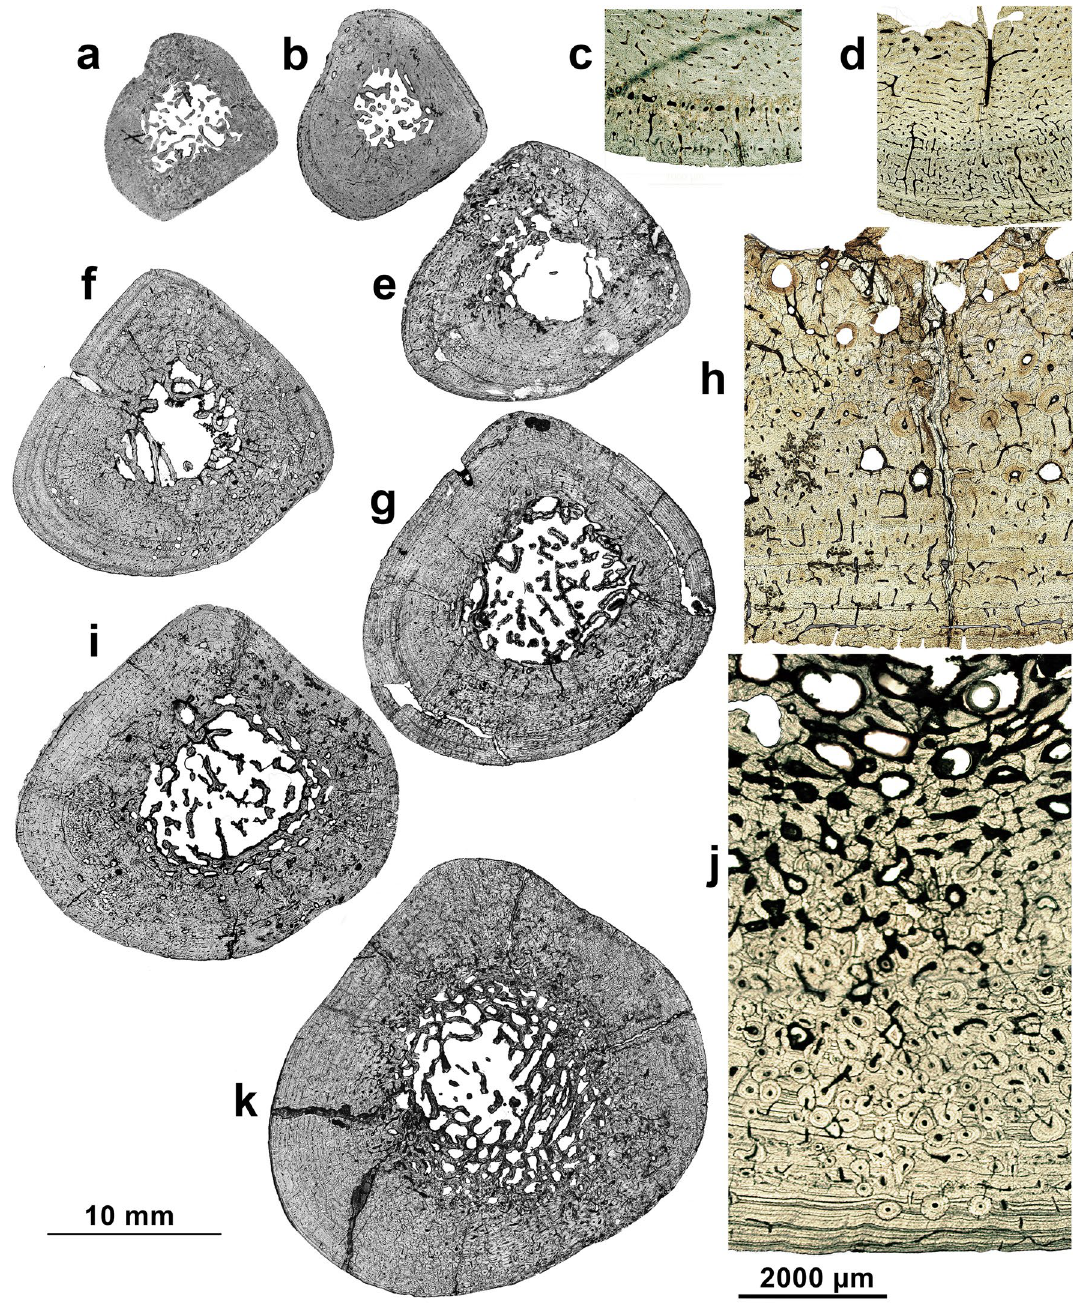
Figure 2. Tibia midshaft sections of P. falconeri . Representation of tissue types in histological sections of an ontogenetic series of tibiae (( a , b , f , e , I , g , k ); anterior crest upper); magnifications ( c , d , h , j ; medullary cavity upper). ( a ) neonate (T106) showing parts of the birth line; ( b , c ) (T1): 1 year; longitudinal and radial osteons after the first winter LAG; ( d ) (T135), ( e ) (T138): 2.5–3 years ‘Fibro-lamellar complex’ (FLC) with longitudinal, oblique and radial osteons; ( f ) (T2): 4 years; ( g ) (T139): 7 years; ( h ) (T 45): 9 years, still showing active growth (open canals at the outer cortex); ( i ) (T142): 11 years; ( j ) (T 203): 22 years, showing an EFS; ( k ) (Roma6): 23 years;. Zeiss Scope A1 microscope with integrated digital camera (AxioCam ICc5), transmitted light. 10 mm scale: complete sections; 2000 µm scale: